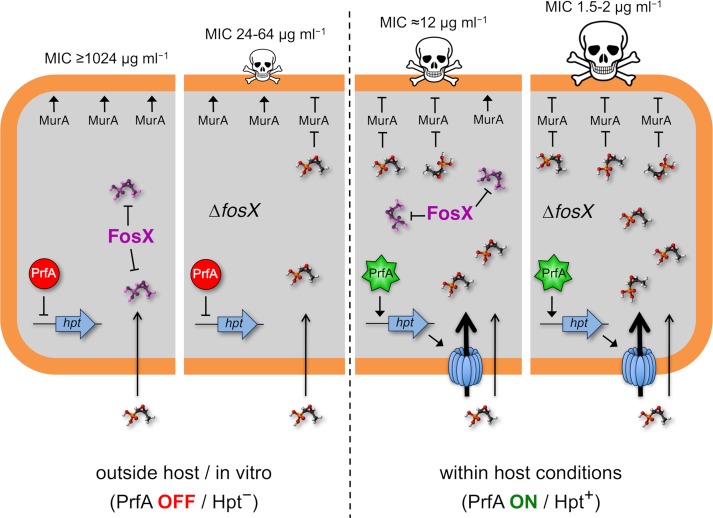
Model of virulence-resistance gene epistatic interaction determining L. monocytogenes fosfomycin phenotype.In saprophytic (in vitro) conditions (left section of figure), the FosX enzyme inactivates the (relatively low) concentrations of fosfomycin that enter the bacterial cell via an uncharacterized transport mechanism (indicated with an inward arrow; see text for details). This fosfomycin uptake mechanism operates in both obligate saprotrophic and pathogenic Listeria spp. However, in L. monocytogenes, two of its virulence determinants, prfA encoding the central virulence regulator PrfA [4], and the PrfA-regulated hpt gene encoding the sugar phosphate permease Hpt [19] (which also transports fosfomycin) [17], suppress the effect of FosX. This occurs during infection, where PrfA is activated upon sensing of host signals [5, 6, 41] and PrfA-promoted expression of Hpt leads to increased fosfomycin influx. In these conditions, FosX is overwhelmed and a fraction of incoming fosfomycin reaches its MurA target at inhibitory concentrations (right section of figure). Fosfomycin is shown in molecular structure representation. MurA catalyzes the first committed step in peptidoglycan biosynthesis (ligation of phosphoenolpyruvate to the 3’-hydroxy group of UDP-N-acetylglucosamine) [11, 36].